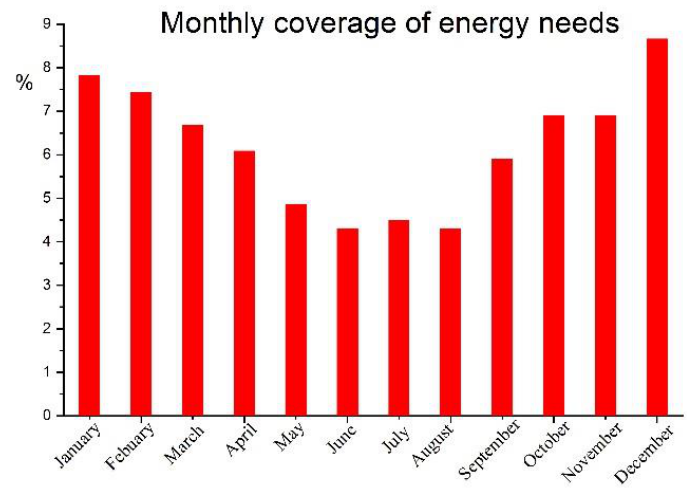
Figure 12. Average monthly coverage of electricity demand from the WT-30 turbine. Table 9. Energy generation and average monthly coverage of electricity demand from the WT-30 turbine.